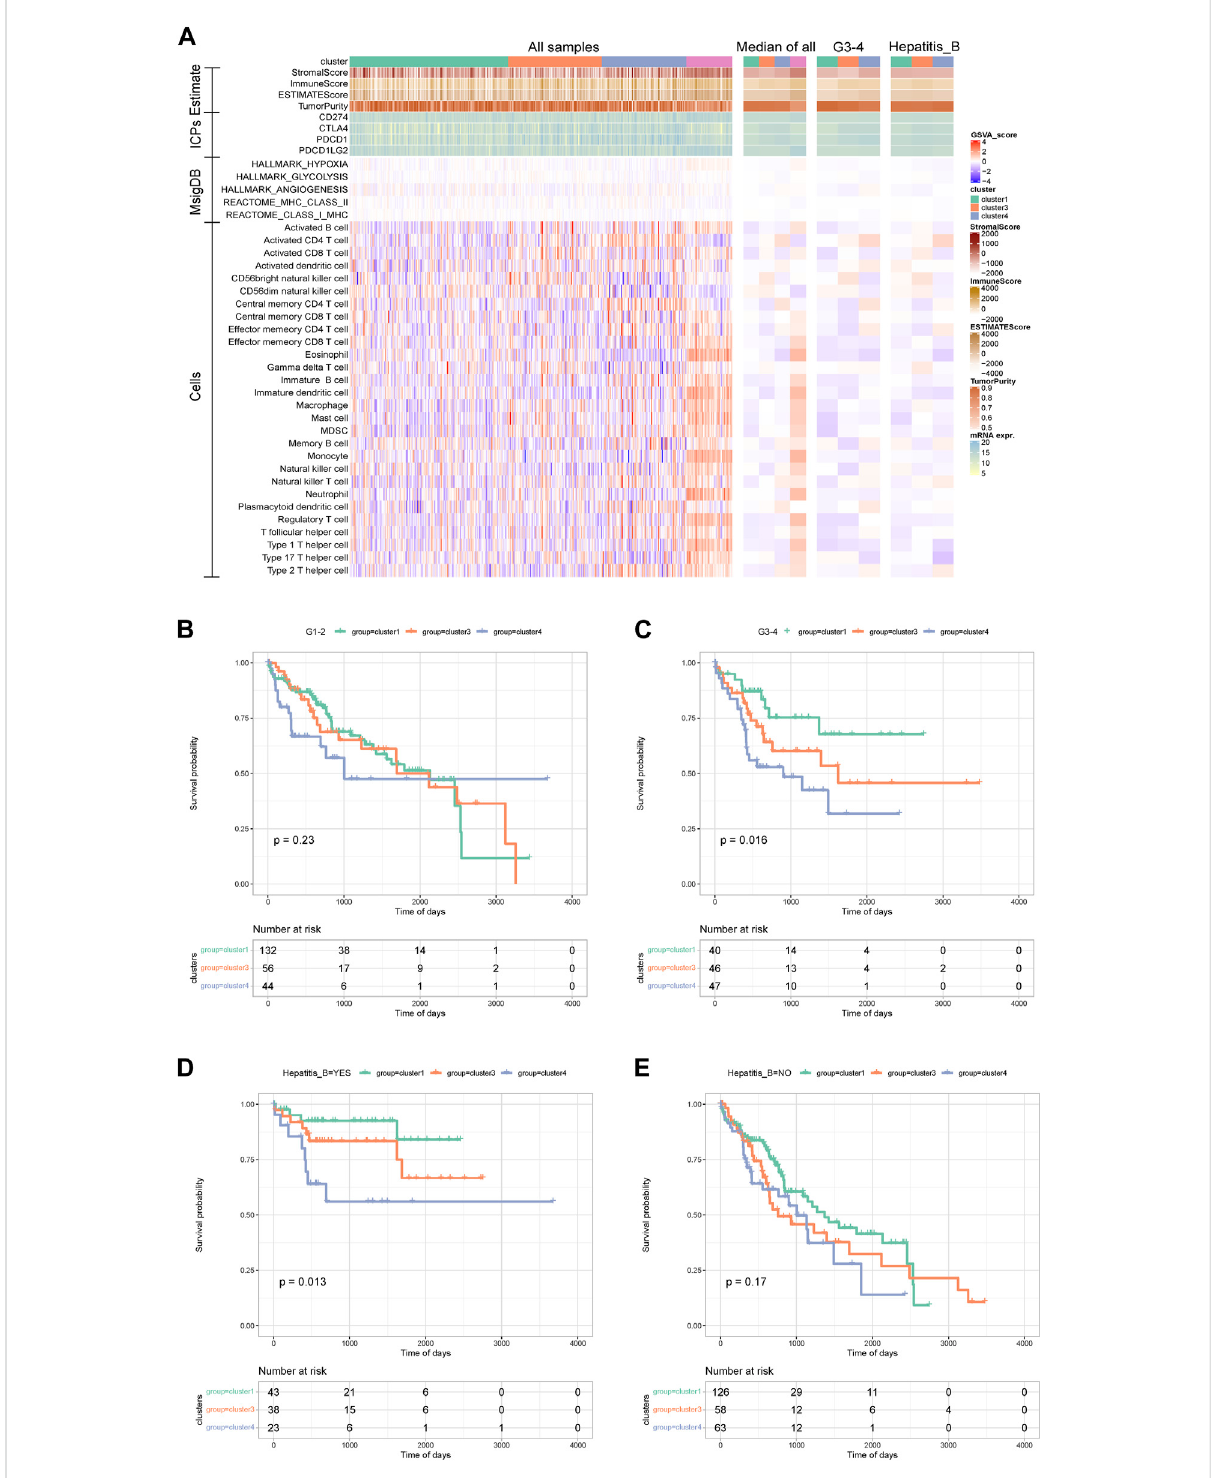
FIGURE 5 Analysis between alternative splicing subtypes and immunity and clinical survival. (A) The heat map shows the immune status of alternative splicing subtypes. (B – E) KM curve between grade group and Hepatitis_B